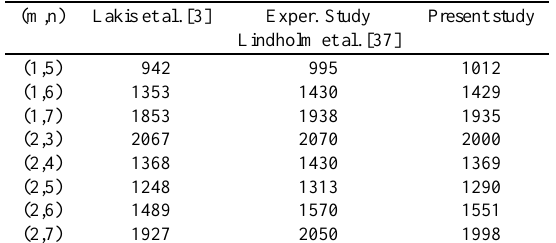
Table 3 Comparison of experimental and theoretical natural